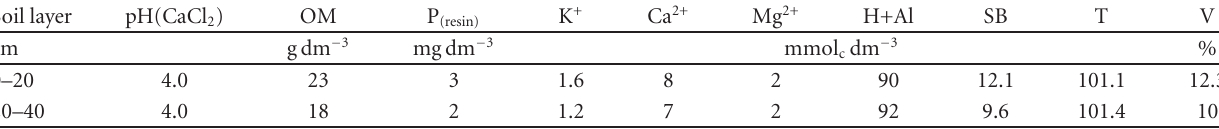
Table 1: Soil chemical analysis (1) of the experimental area (average values) before banana cropping.